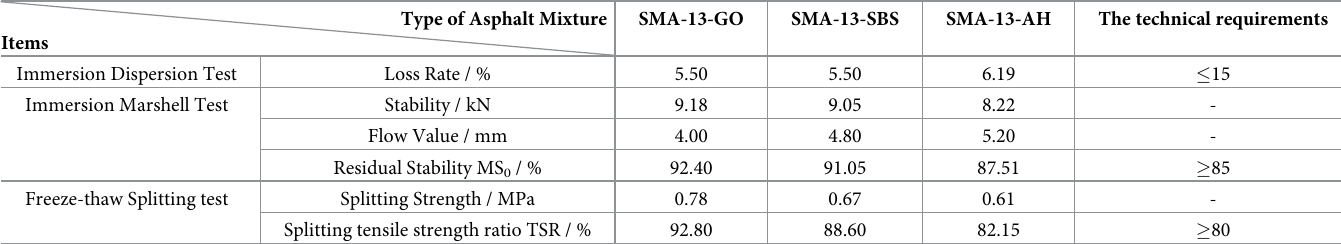
Table 8. The water stability performance of 3 asphalt